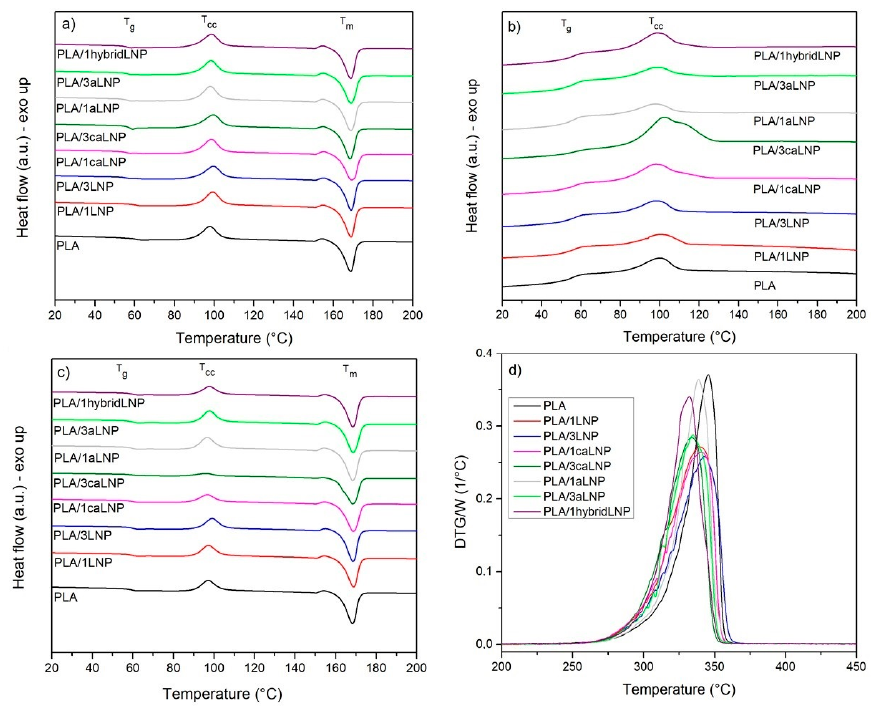
Figure 4. Thermal properties of PLA and PLA nanocomposite films (differential scanning calorimetry (DSC) and derivative thermogravimetric (DTG)): ( a ) first heating; ( b ) cooling; ( c ) second heating and ( d ) DTG data. Table 2. T onset and T max values calculated for PLA and PLA nanocomposite films.